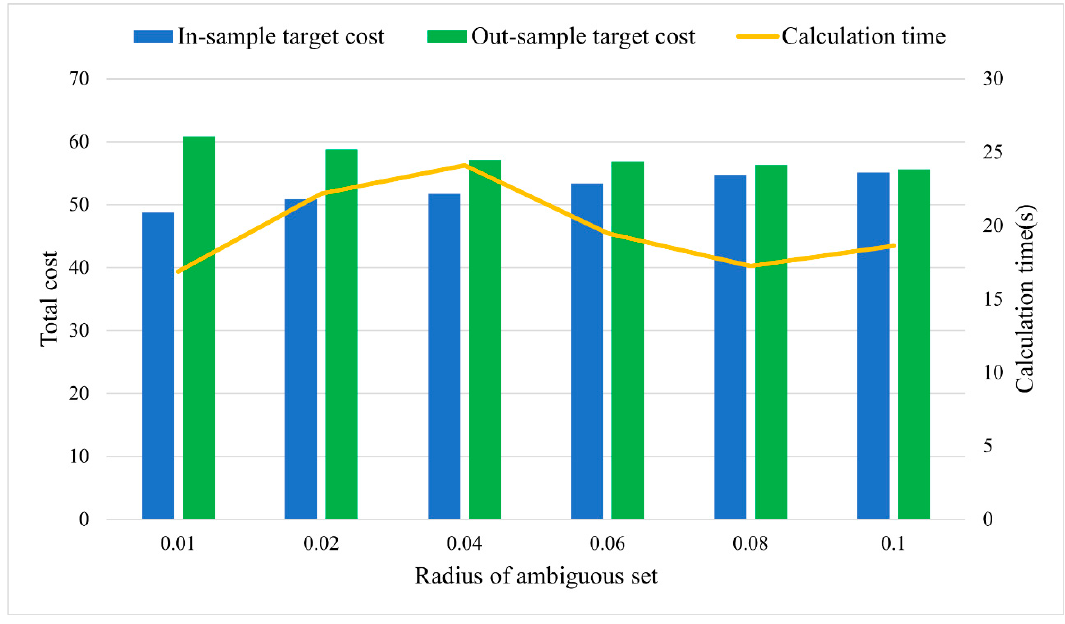
Figure 4. Sensitivity analysis of